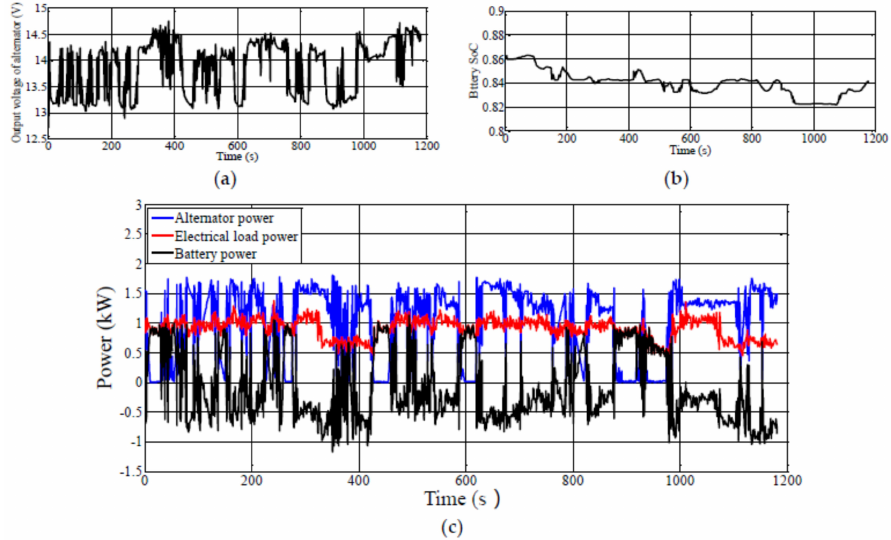
Figure 9. Experimental results for the proposed algorithm ( a ) alternator voltage, ( b ) battery SOC, and ( c ) alternator, load, and battery power